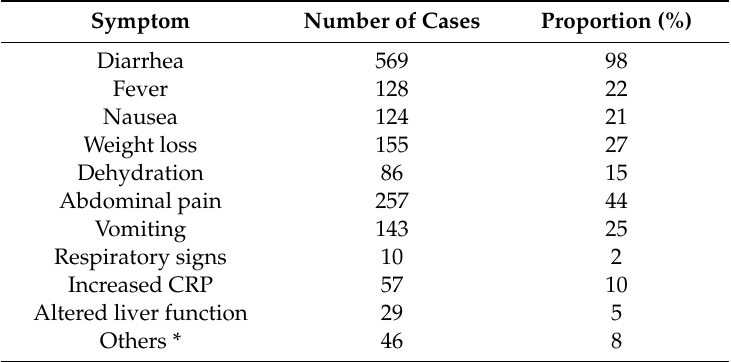
Table 3. Recorded symptoms in cryptosporidiosis reported